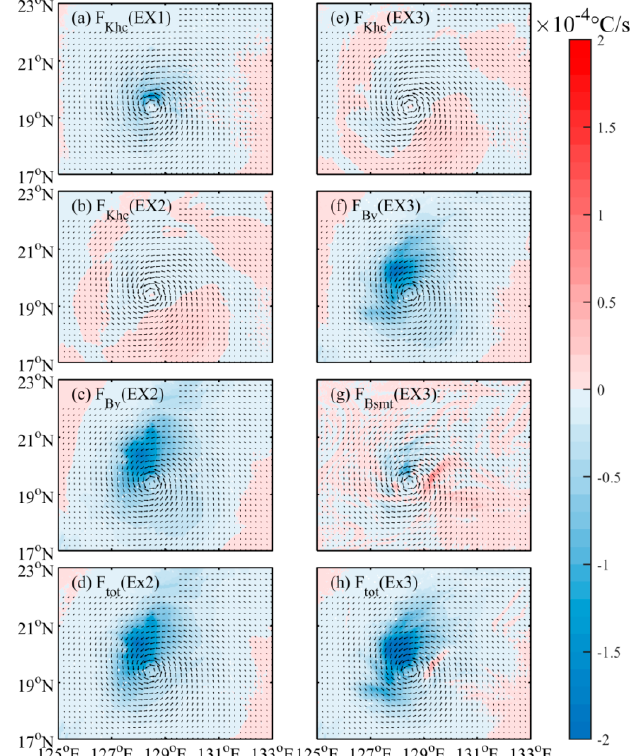
Figure 14. Horizontal distributions of the surface temperature Reynold flux of the three experiments at 0600 UTC 6 Jul 2005. a, d, and h show the total temperature Reynold flux of the EX1, EX2, and EX3. b and e show the turbulence-induced temperature Reynold flux of the EX2 and EX3. c and f show the WITM-induced temperature Reynold flux of the EX2 and EX3. g shows the WTFR-induced temperature Reynold flux of the EX3. The vector shows the model wind data.